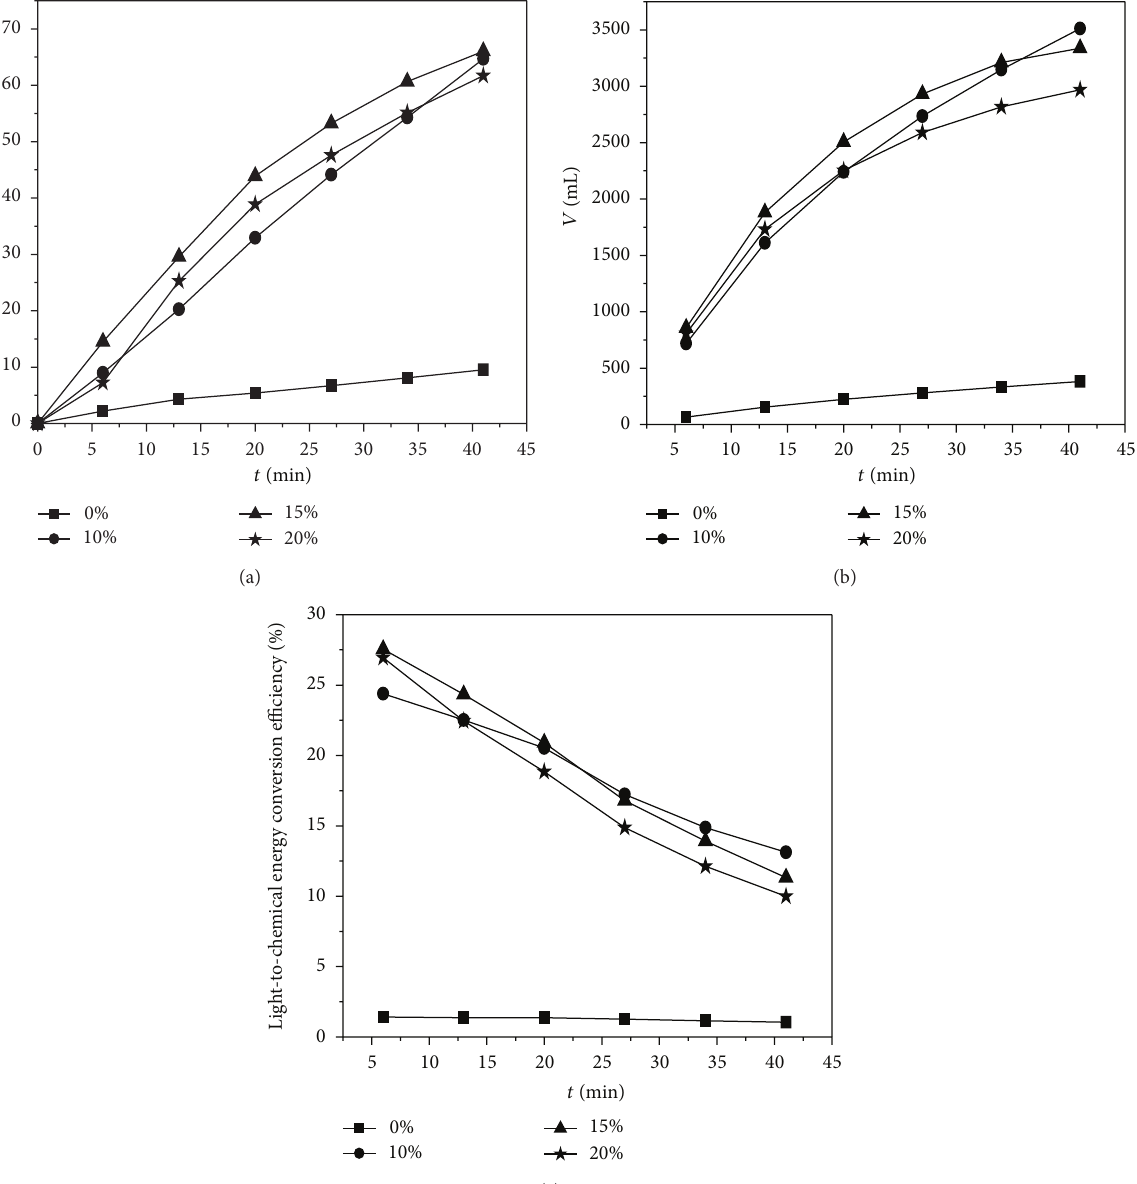
Figure 4: (a) Carbon conversation; (b) hydrogen production; (c) energy conversation efficiency during